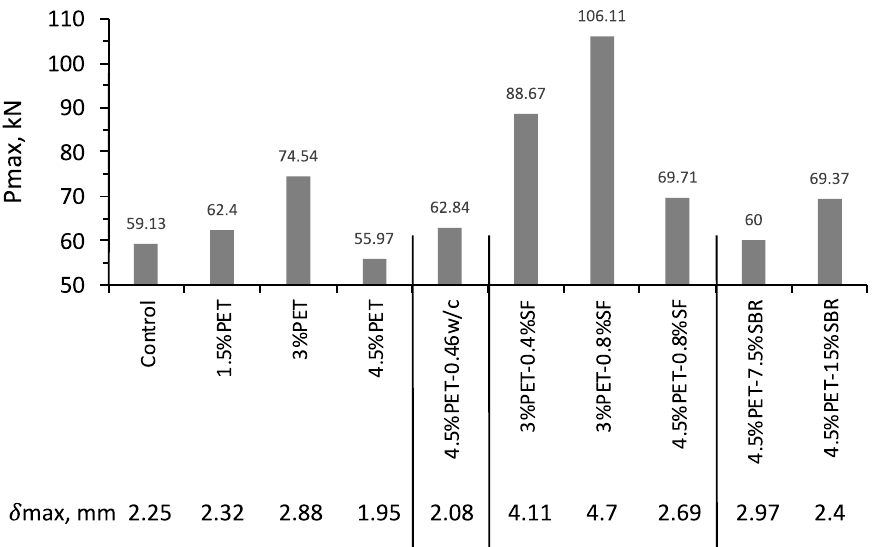
Figure 8. Effect of concrete modification on P max and δ max for RC beams without stirrups.